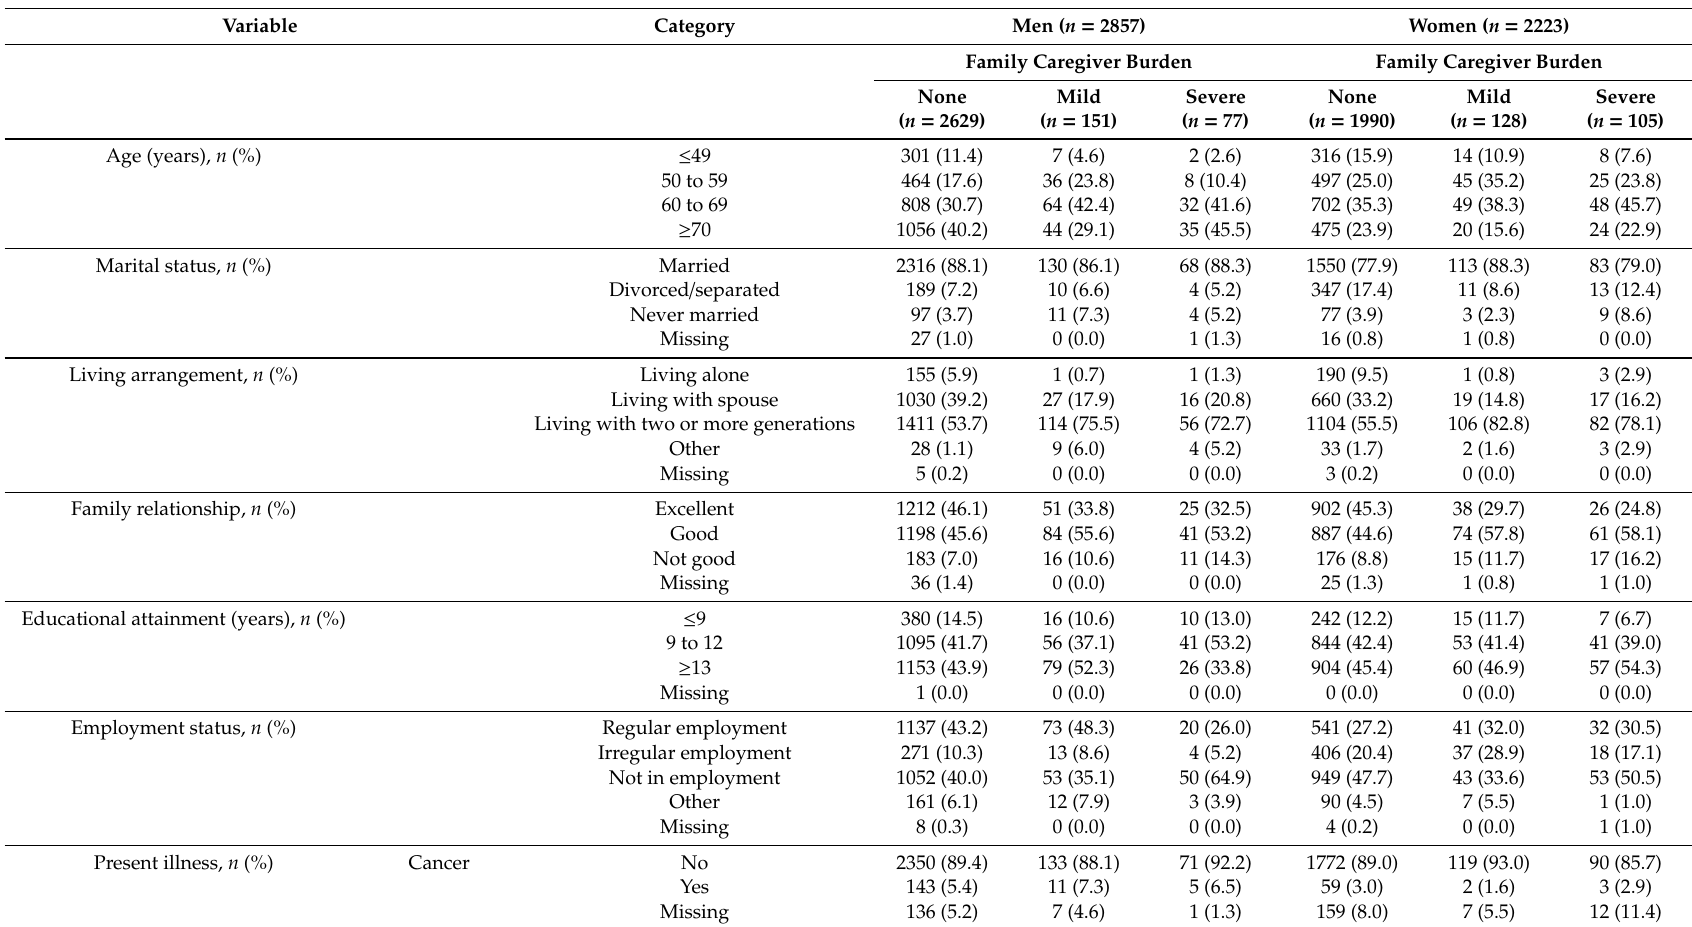
Table 1. Characteristics of